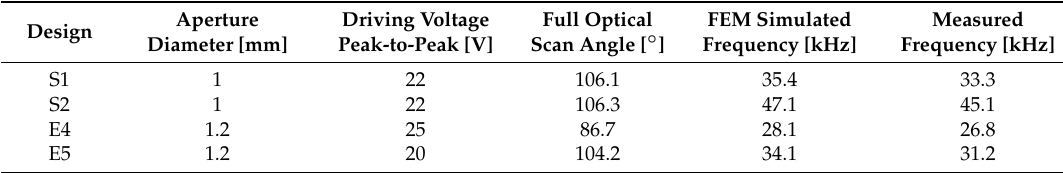
Table 2. The characterization results of Design S1, S2, E4 and E5.